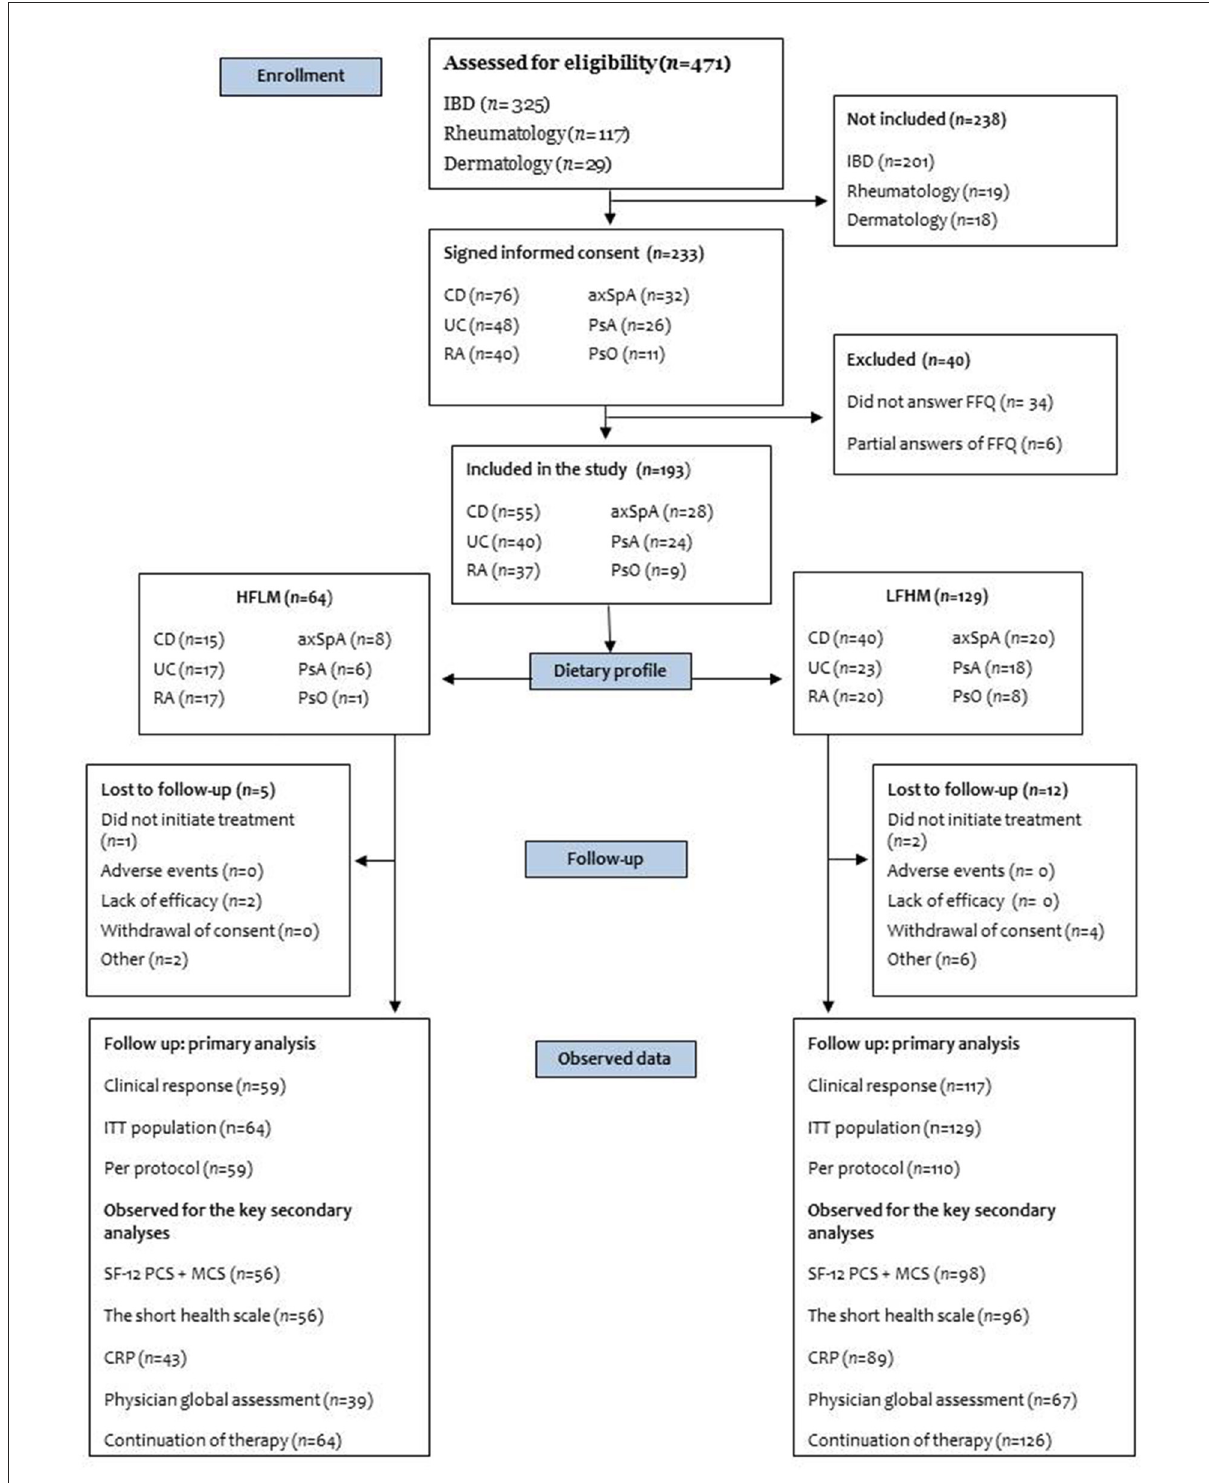
FIGURE1 Flow chart of the enrolment of participants. Number of Chronic Inflammatory Disease patients who were screened, included in the study and included in the analysis. Patients screened for eligibility were not explicitly recorded in the study. For CD, UC, and PsO we estimated a number based on the mean inclusion rate from two clinics that kept a pre-screening log. For RA, axSpA, and PsA, the number is not an estimate but the total number of patients that initiated biologic treatment in the clinic during enrolment. IBD, Inflammatory bowel disease (Crohn’s disease and Ulcerative colitis); CD, Crohn’s disease; UC, Ulcerative colitis; RA, Rheumatoid arthritis; axSpA, Axial spondyloarthritis; PsA, Psoriatic arthritis; PsO, Psoriasis; FFQ, Food Frequency Questionnaire; HFLM, high fibre/low meat; LFHM, low fibre/high meat; ITT, intention-to-treat; SF-12 PCS + MCS, short form health survey the physical and mental component summary, The short health scale includes four health dimensions (symptom burden, functional status, disease-related burden and general wellbeing); CRP, C-reactive